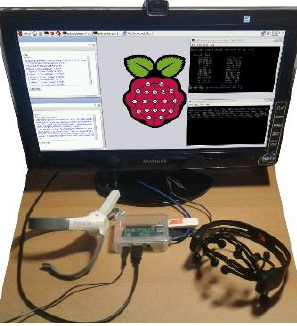
Figure 2 The Neuroberry connected to a monitor through HDMI for demonstration purposes.